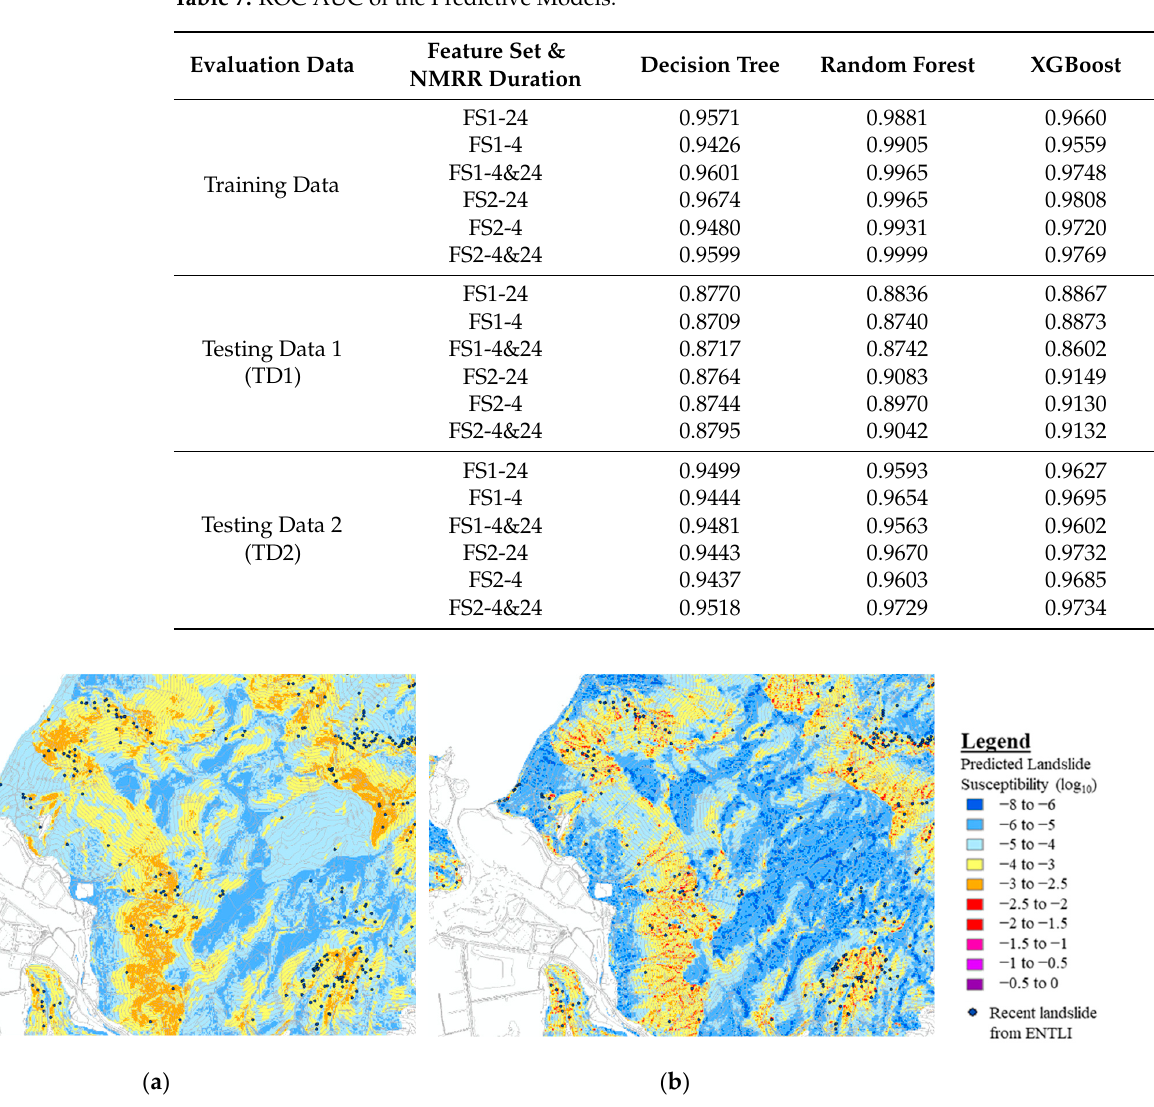
Table 7. ROC AUC of the Predictive Models.